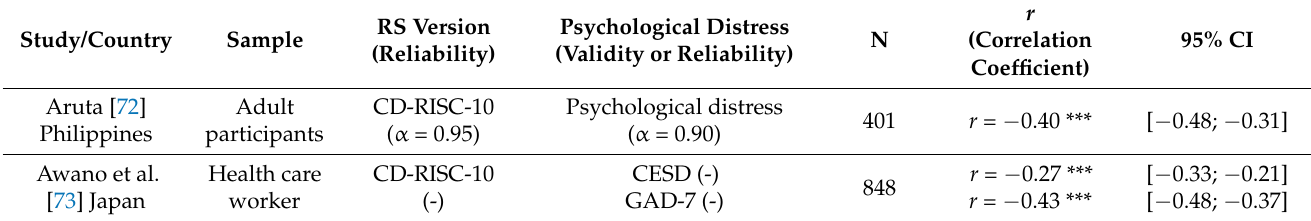
Table 1. Descriptive characteristics of and associations between resilience and psychological distress in the